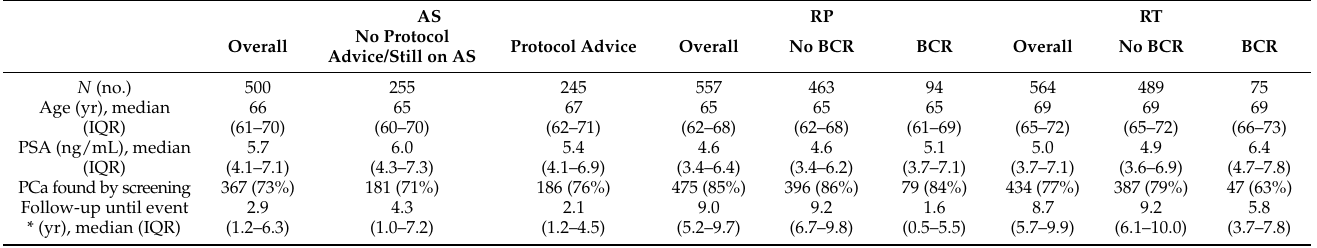
Table 1. Patient